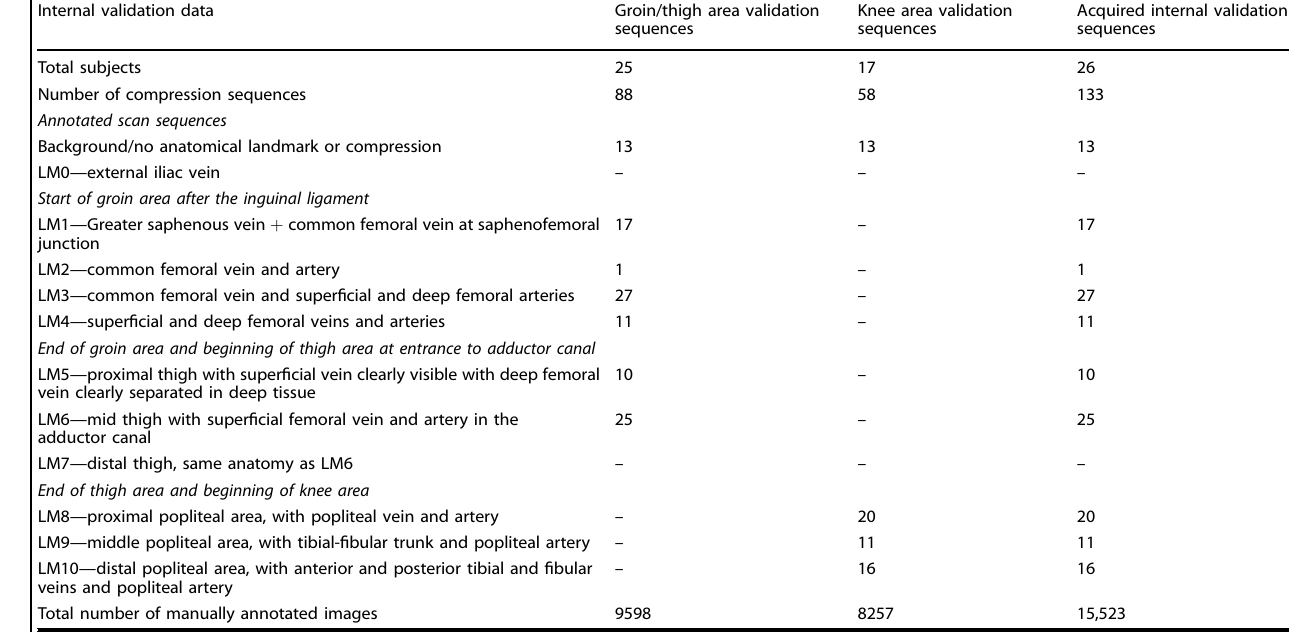
Table 8. The internal validation set represents a random 10% split at the subject level of the overall available training data.